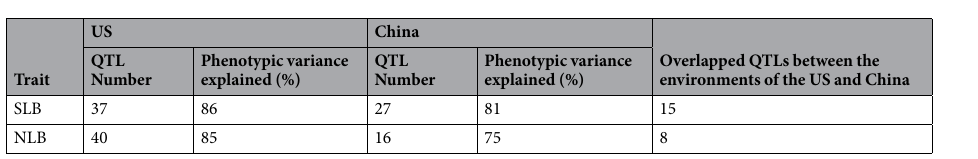
Table 1. QTLs identified by joint linkage mapping of SLB and NLB resistance. SLB, southern leaf blight; NLB, northern leaf blight; US, the United